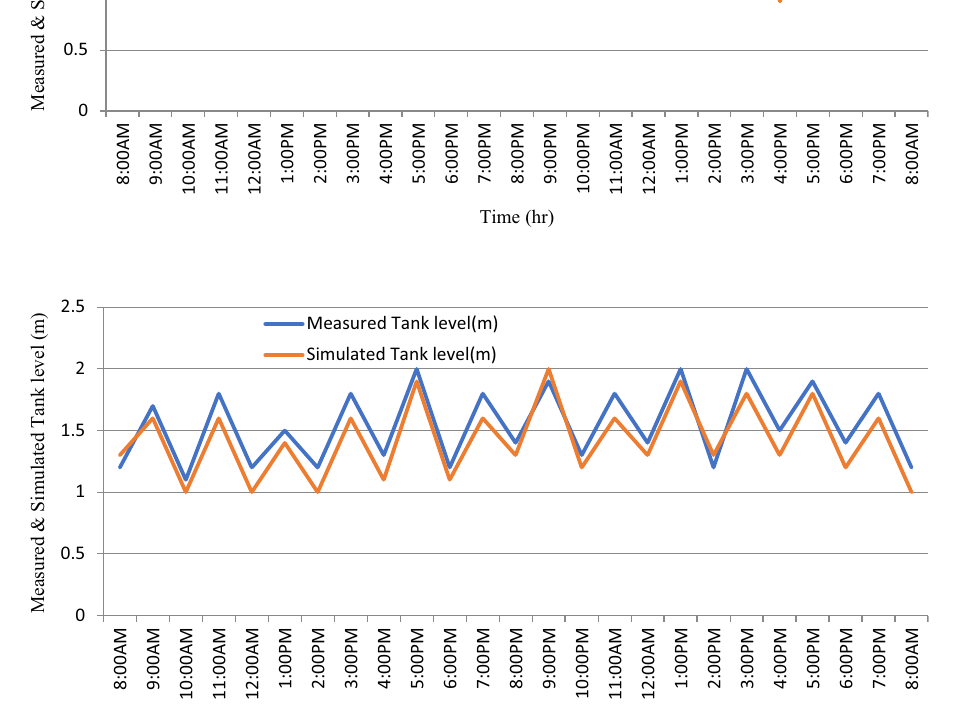
Fig. 8 Calibration of Tank level during average daily demand